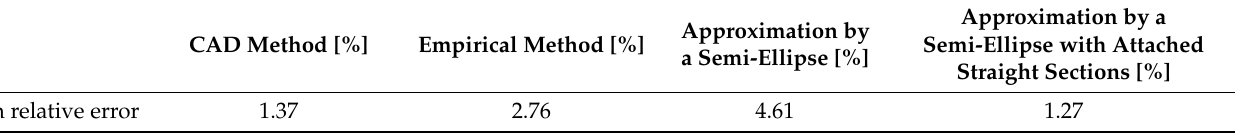
Table 5. Mean relative errors for four methods compared with the scanning